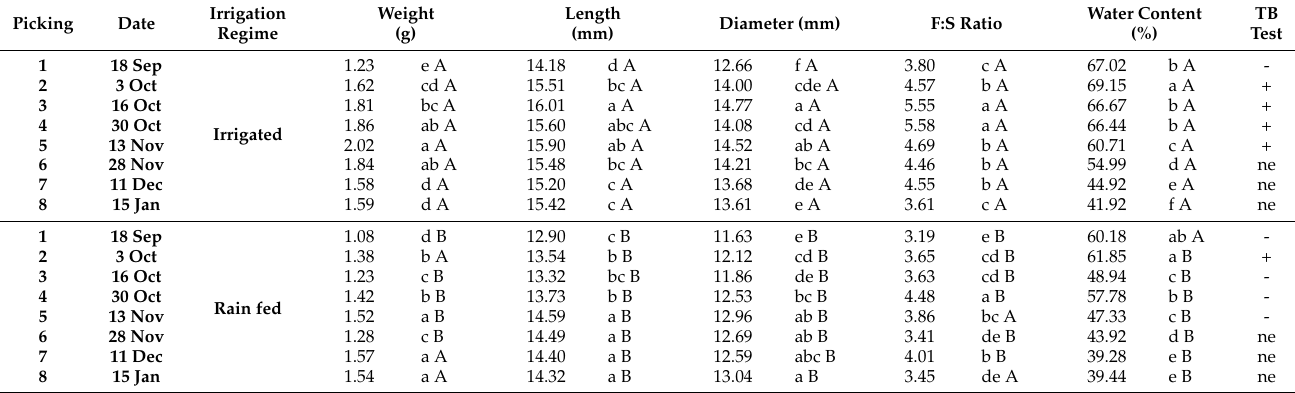
Table 2. Physical characteristics and toluidine blue test of ‘Arbequina’ olives picked at El Soler à s (PDO “Les Garrigues”) during the 2017–2018